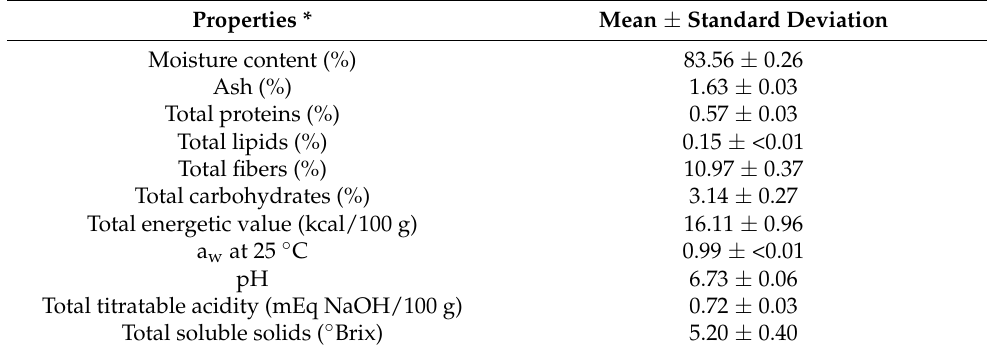
Table 1. Proximate composition and physical–chemical properties of the purple basil leaf ( Ocimum basilicum L.). Properties * Mean ± Standard Deviation Moisture content